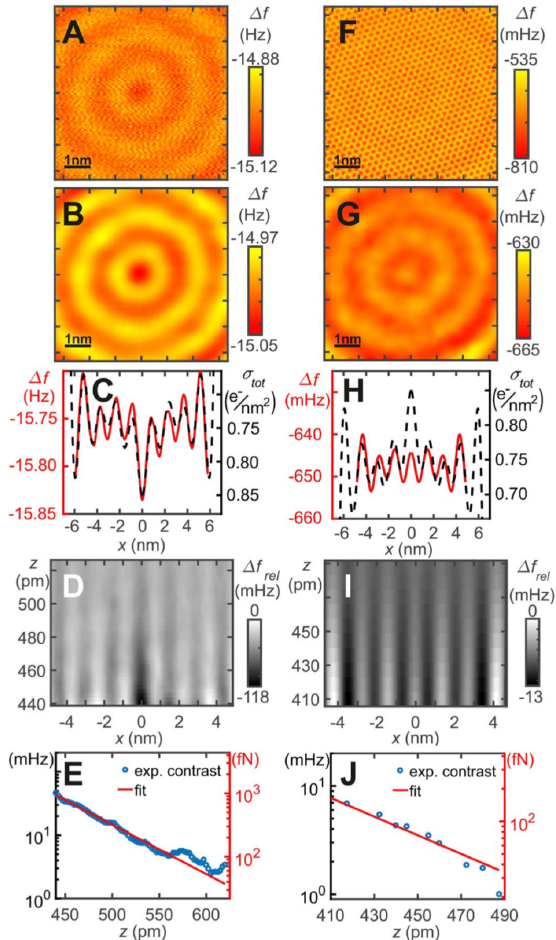
Figure 20. AFM data inside the quantum corral for a single atom metal tip (left column) and a CO terminated tip (right column). ( A ) Frequency shift data ∆ f ( x , y , z = const . ) with an attractive interaction between the probe tip and the Bessel–type eigenstates. ( B ) Low–pass filtered version of A. ( C ) Profile line through the center of B and reversed total surface charge density of the corral. ( D ) Gray scale representation of offset and slope corrected frequency shift ∆ f rel ( x ,0, z ) . ( E ) Distance dependence of the contrast, defined as the difference between the average of the first and second maxima and the minimum in between. ( F ) Frequency shift data ∆ f ( x , y , z = const . ) , showing attraction to the Cu surface atoms and repulsion to the Bessel-type eigenstates. ( G ) 10 Low-pass filtered version of F, showing only the repulsion to the Bessel-type eigenstates. ( H ) Profile line through center of G compared to total charge density. ( I ) Gray scale presentation of offset and slope corrected frequency shift ∆ f rel ( x ,0, z ) . ( J ) Contrast, defined by the difference between the first maximum at x ≈ ± 1.3nm and the average between the first and second minimum, evolution as a function of vertical distance z . See section 7 of [84] for details of data extraction. Adapted with permission by American Association for the Advancement of Science from Figure 2 in